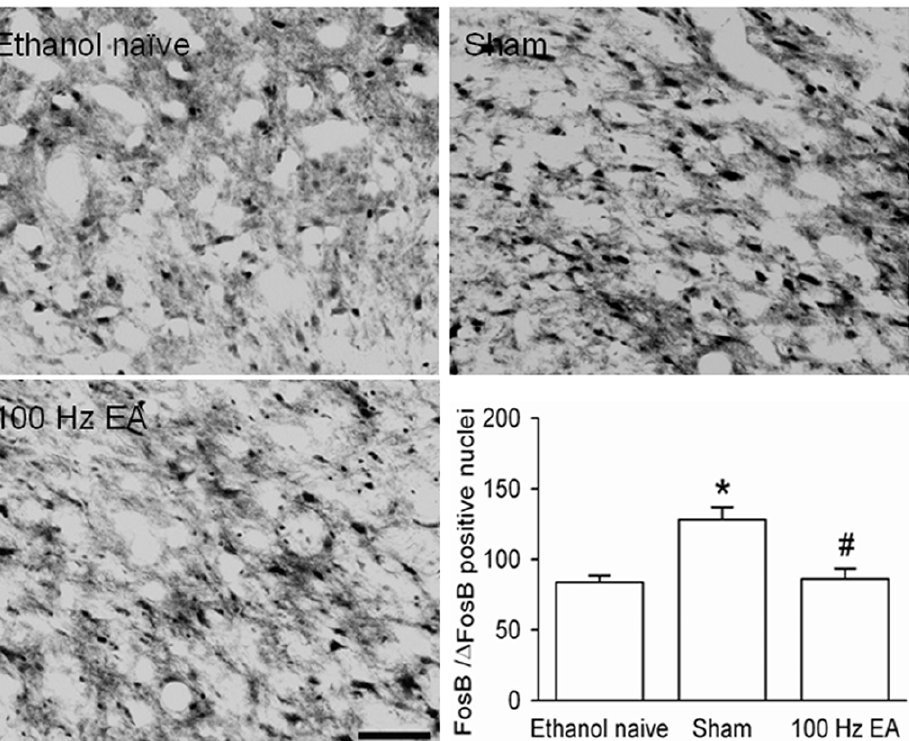
Figure 8. Photomicrographs depicting typical brain regions of analysis for the posterior VTA. Panels indicate FosB/ D FosB-positive cells in animals that were drinking water (ethanol naı¨ve), drinking large amounts of ethanol treated with sham (Sham), and drinking large amounts of ethanol treated with multiple sessions of 100 Hz EA (100 Hz EA). Increased numbers of FosB/ D FosB-positive nuclei were observed in the posterior VTA in rats that chronically consumed large amounts of ethanol with sham treatment, as compared with ethanol naive animals. Multiple sessions of 100 Hz EA decreased the accumulation of FosB/ D FosB in the VTA induced by excessive ethanol consumption. Data are expressed as mean 6 S.E.M. * indicates significant difference from ethanol naı¨ve ( p , 0.001), # , a significant difference from sham ( p , 0.001). Scale bar=200 m